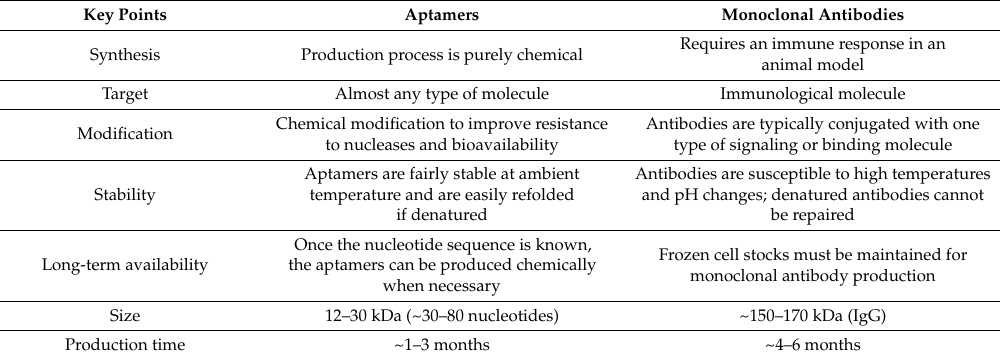
Table 1. Comparison between DNA/RNA aptamers and monoclonal